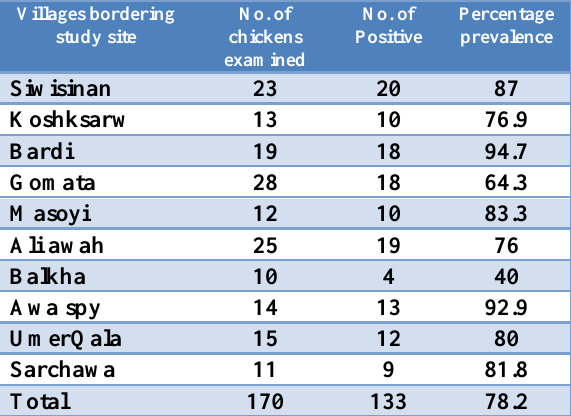
Table, 1: Prevalence of blood parasites in local chickens ( Gallus domesticus ) in Qaradagh, Sulaimani, Kurdistan region/ Iraq 2012 Villages bordering study site